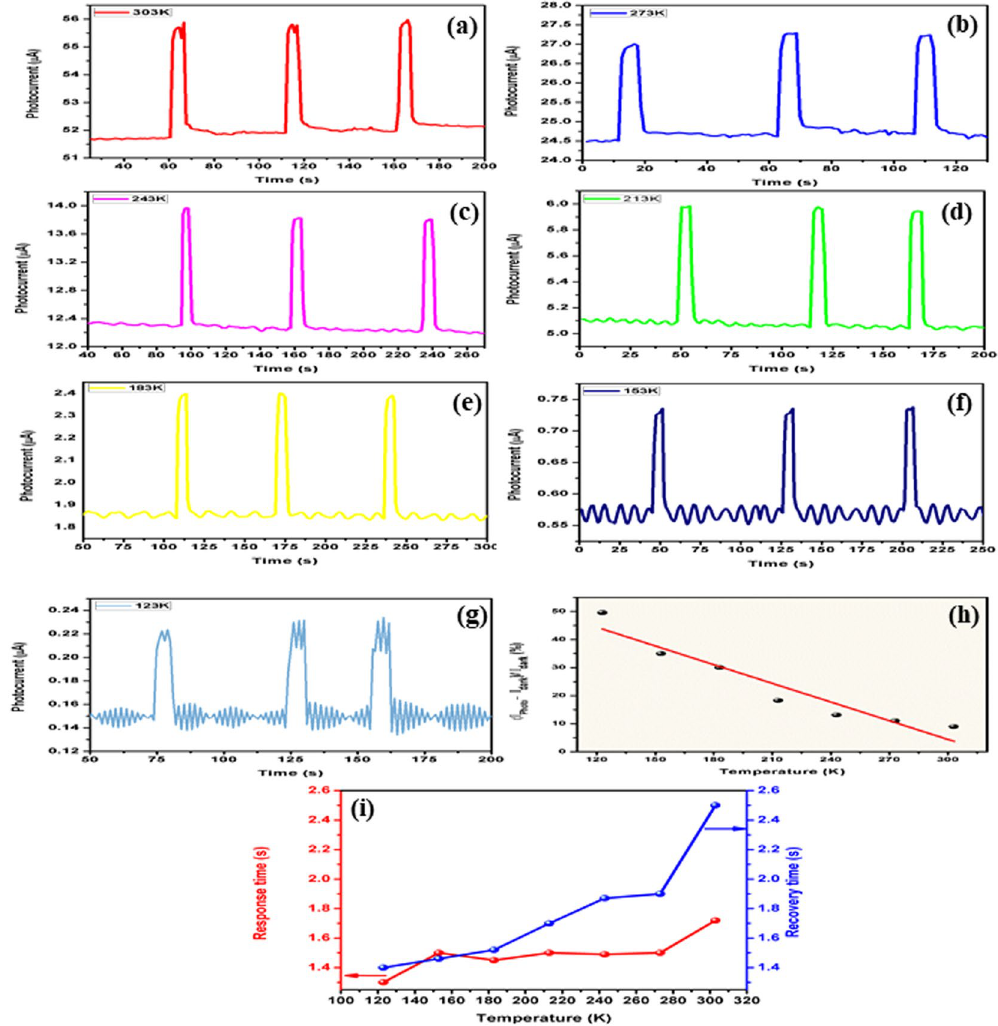
Figure 6. ( a – g ) Photoconductive responses ( h ) sensitivity, and ( i ) response and recovery time of rGO based sensor observed at low temperature (303K–123K) of